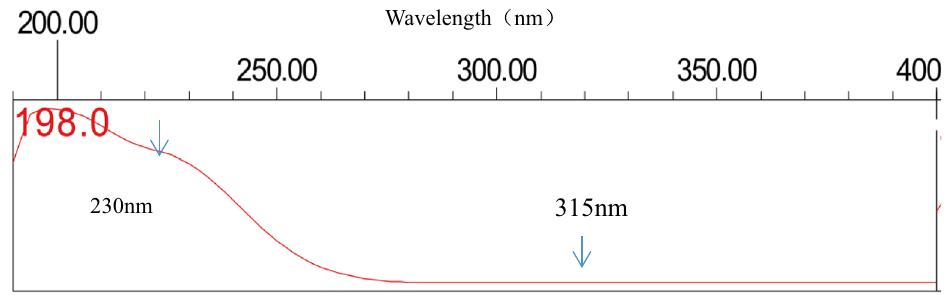
Figure 3. UV spectrum of photolytic degradant of